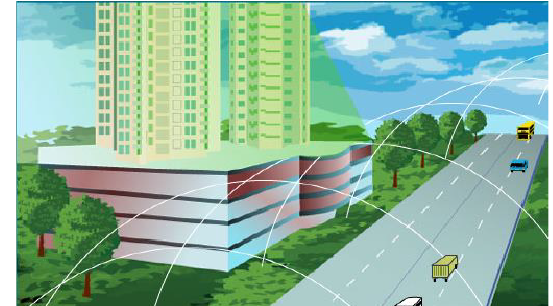
Figure 5 – Reducing traffic noise with objects Рис . 5 – Снижение дорожно - транспортного шума с помощью объектов